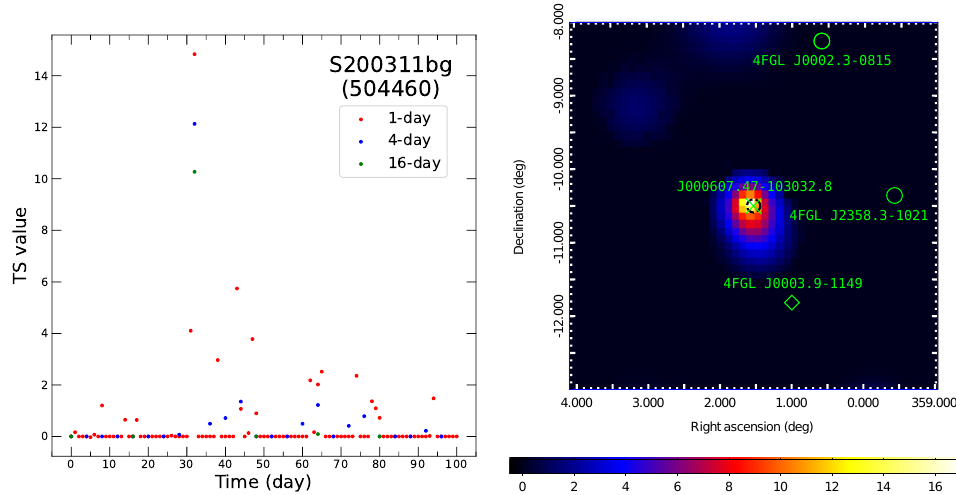
Figure 2. ( Left ) The 1-, 4-, 16-day binned TS curves from − 1 to 100 days of the BBH merger trigger S200311bg obtained for J000607.47 − 103032.8 (504460). A TS ≥ 9 event is seen at 31 days in all the TS curves. ( Right ) The 0.3–500GeV TS map with a size of 5 ◦ × 5 ◦ made from the 1-day bin data that corresponds to TS (cid:39) 15. The 4FGL sources in the field are marked with circles or a diamond, the latter indicating a Log-Parabola spectral form for the source. The position of the target galaxy is marked with a cross, while the dashed black circle is the 2- σ error circle (radius 0.09deg) determined for the candidate γ -ray source. Table 3. Information for a candidate short flaring event in the field of S190408an. Source (Serial Number)